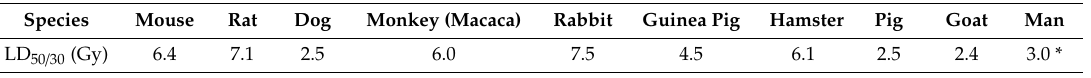
Table 1. Approximate values of LD 50 / 30 for various mammalian species irradiated with X-rays. Species Mouse Rat Dog Monkey (Macaca) Rabbit Guinea Pig Hamster Pig Goat Man LD 50 / 30